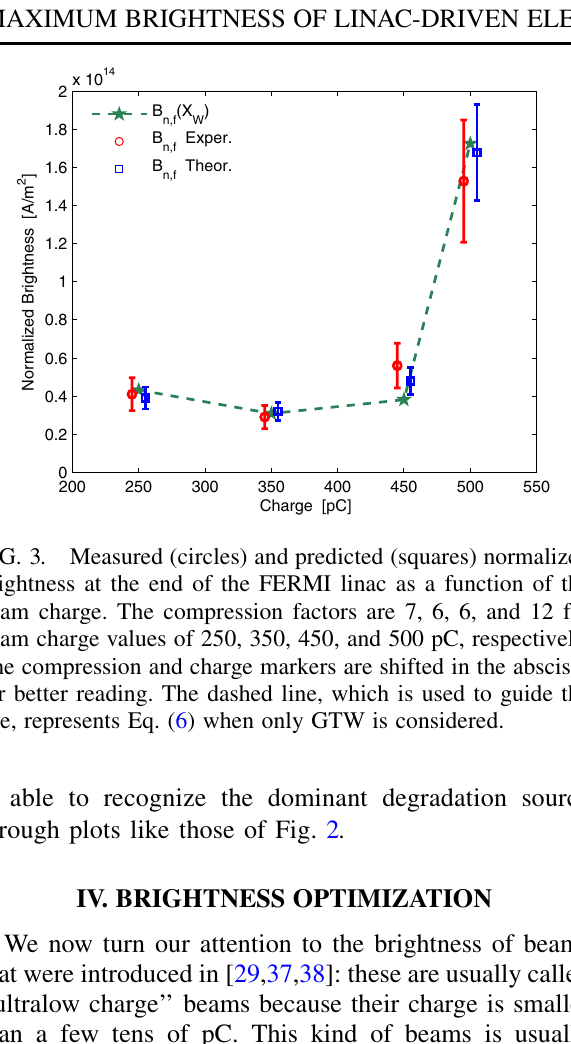
existing facilities appears reachable.